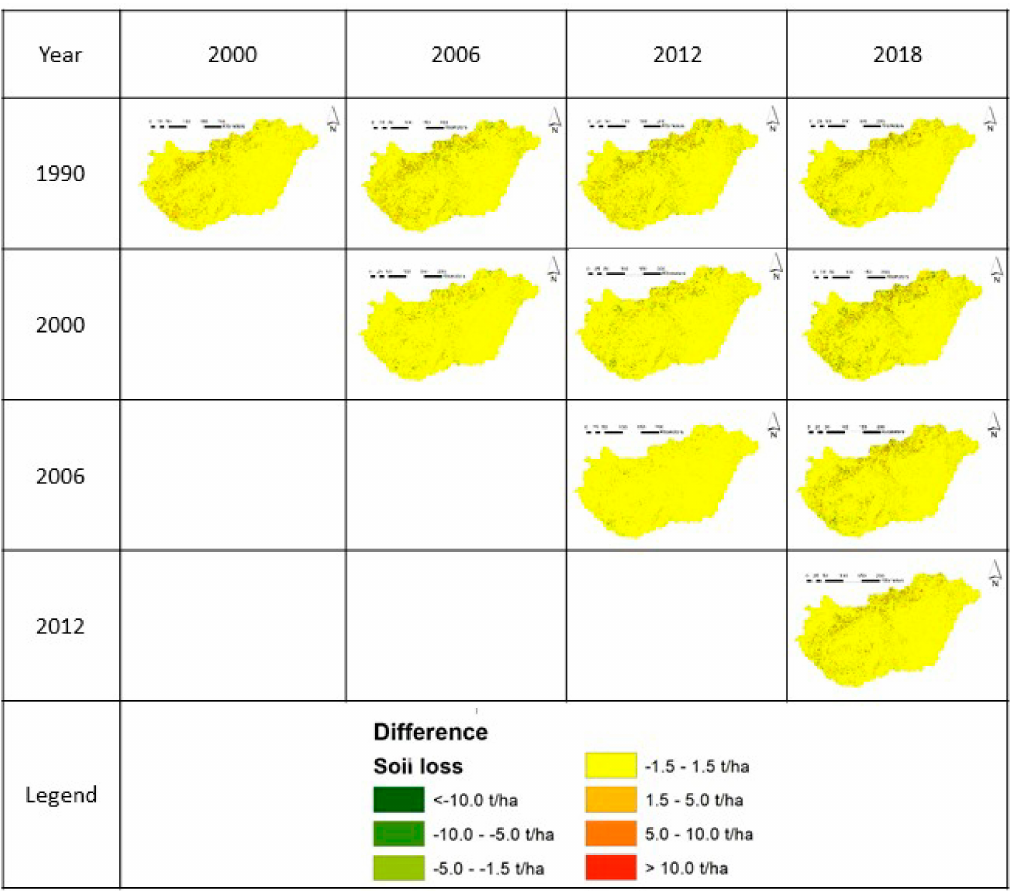
Figure A2. Changes in erosion estimates between the observed years (PESERA and USLE models